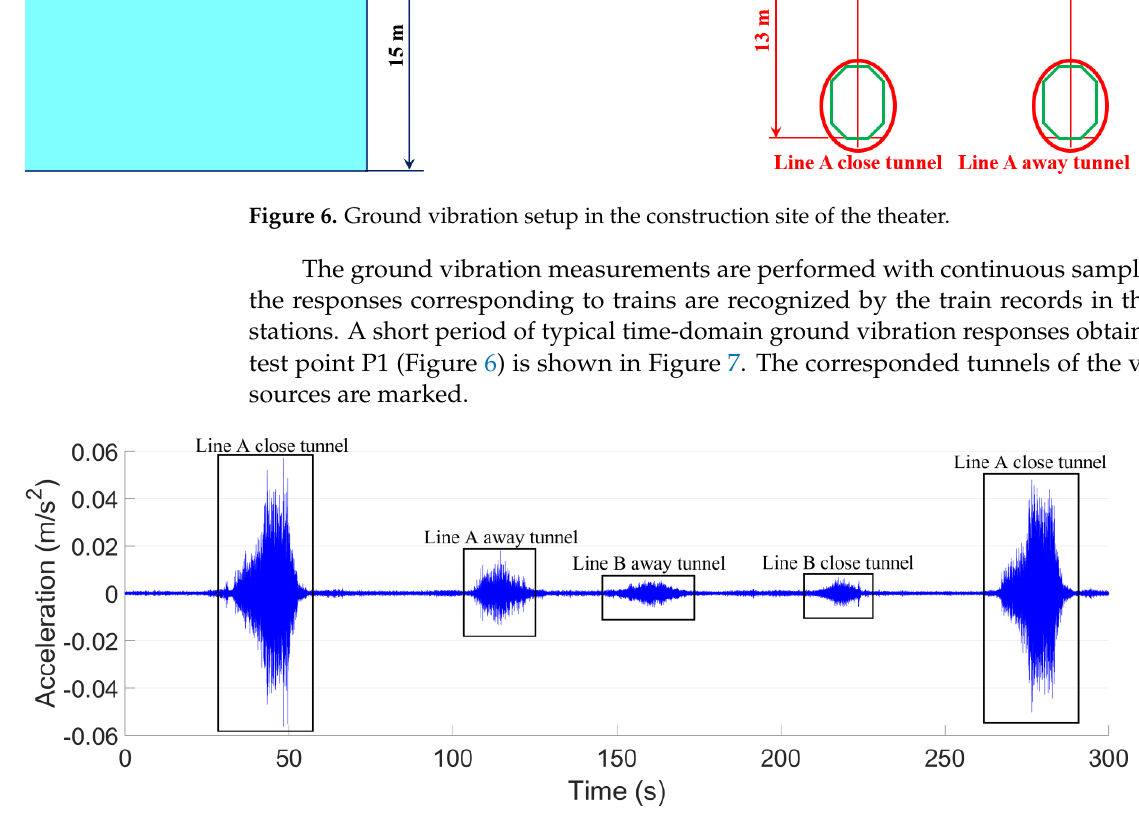
Figure 8. Ground 1/3 octave frequency division vibration acceleration level of Line A and Line B in P1. The VL max induced by the train from the Line A close tunnel is 67 dB with the corre- sponded frequency band of 63 Hz. Such a result is 7 dB higher than that of Line A away tunnel, and more than 13 dB higher than those of Line B tunnels. It has to be noted that in the frequency range of 6.3 – 16 Hz, the vibration responses due to the trains from the Line A away tunnel are higher than those from the Line A close tunnel, which is likely caused by the interference of the metro tunnel (Line A close tunnel) on the vibration propagation. It can be concluded that the ground vibration induced by the trains from the Line A close tunnel has the highest impact on the proposed theater. Therefore, in the further anal- ysis of vibration propagation, only the trains from the Line A close tunnel are taken into account. The vibration levels from P1 to P4 induced by the trains from the Line A close tunnel are calculated, as presented in Figure 9.